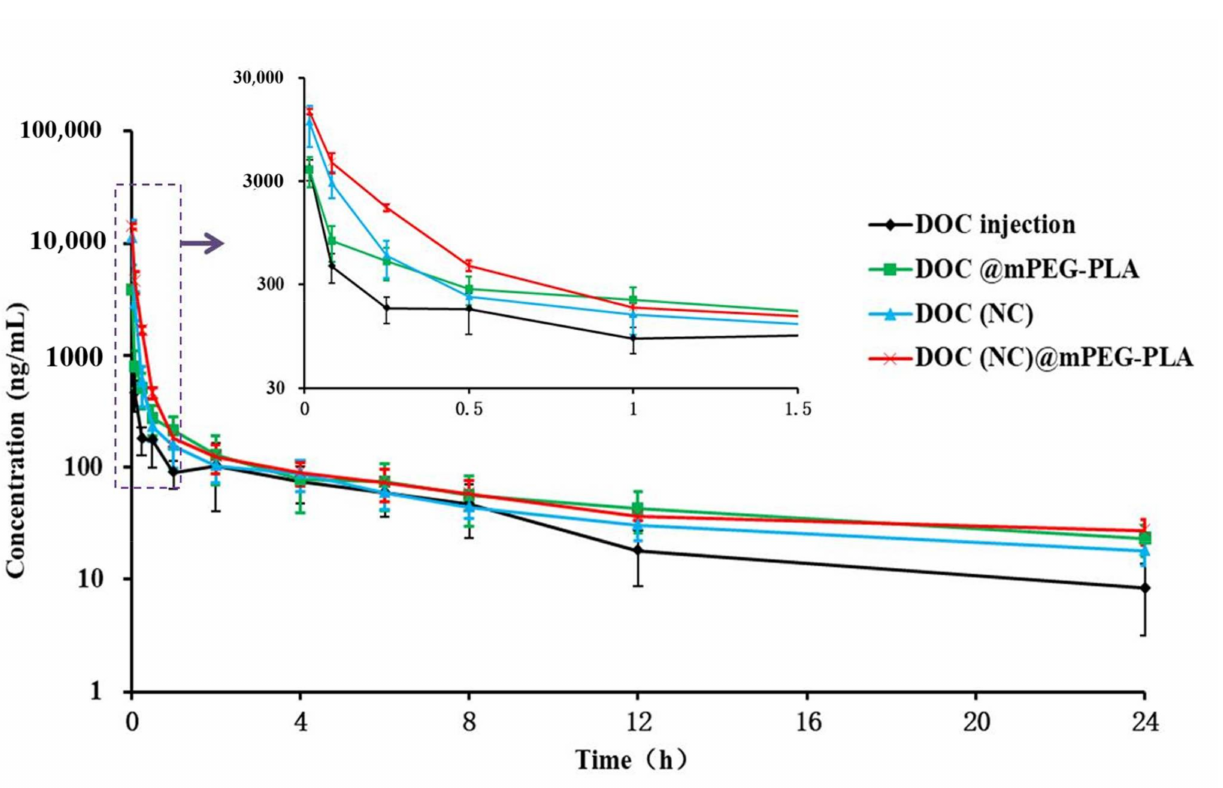
Figure 8. The concentration–time curves of different formulations on rats via intravenous route at 10 mg/kg ( n =